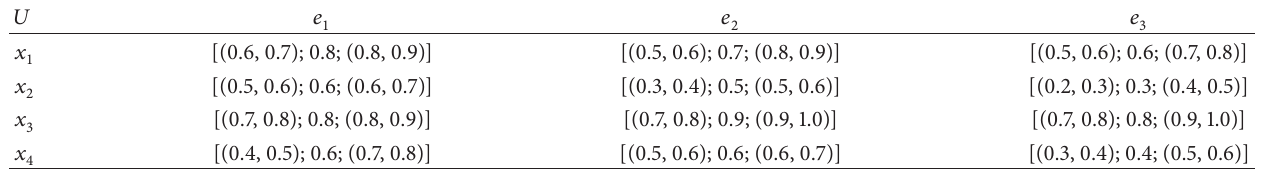
Table 5: Evaluation value of the third year.